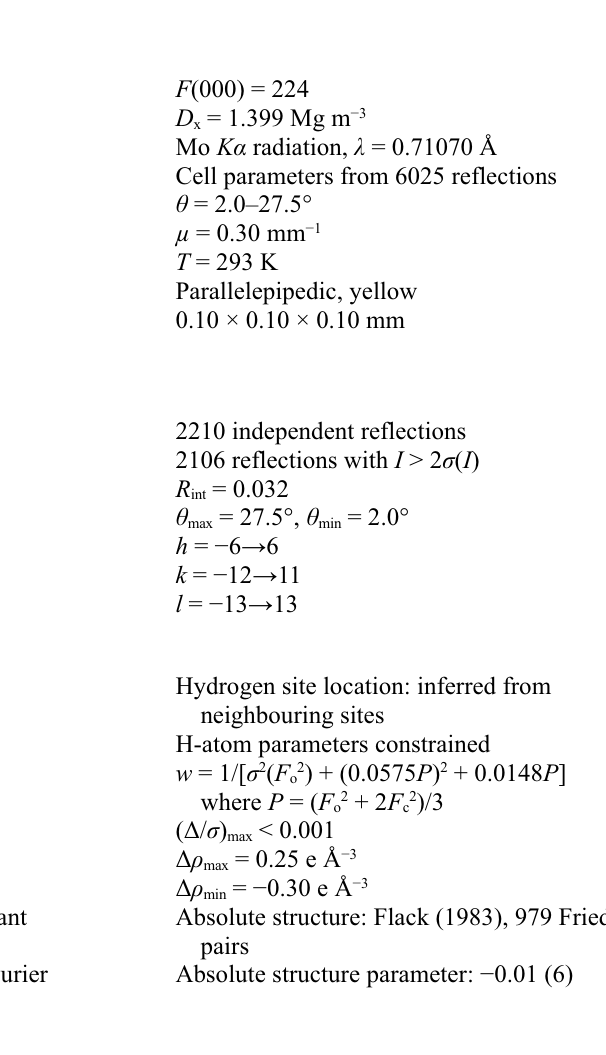
Figure 3 Chemical pathway of the formation of (I)